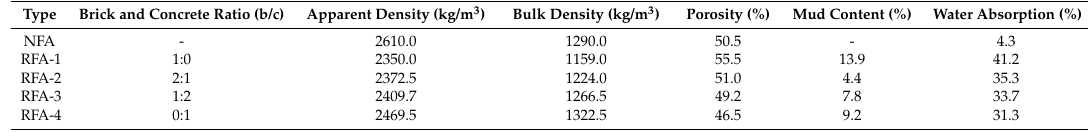
Table 1. Physical properties of recycled aggregate and natural